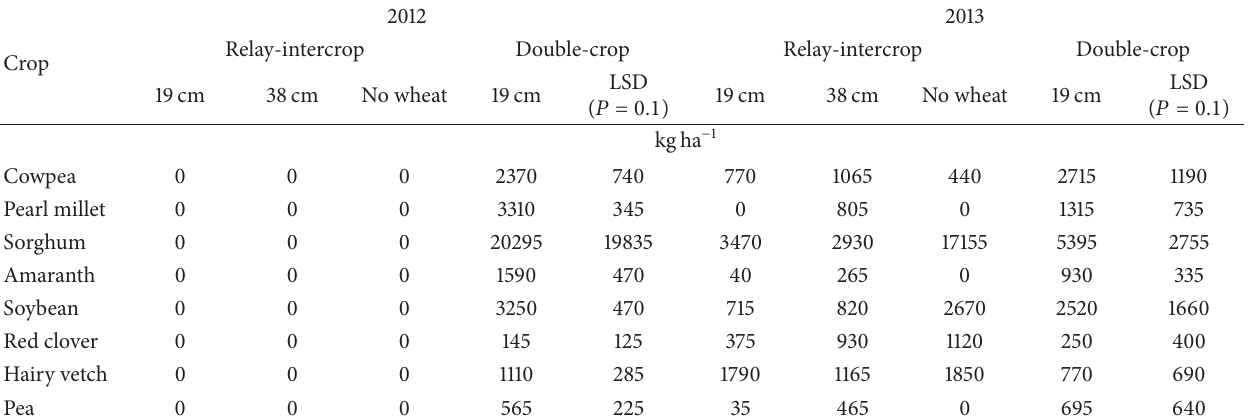
Table 4: Dry biomass yields of alternative crops for 2012 and 2013.